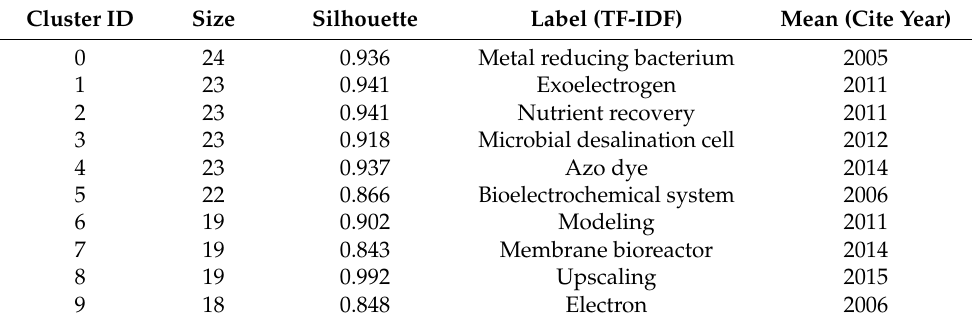
Table 5. Summary of the largest 10 clusters on MFCs in wastewater treatment.